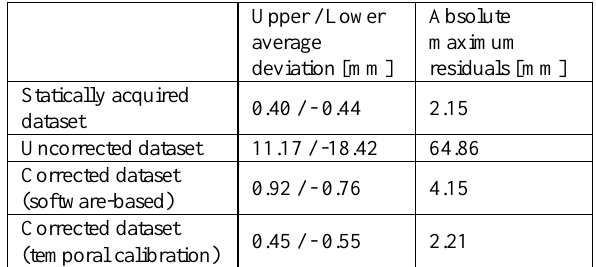
Figure 5: Model ship with mounted prisms (circles) and targets (dashed rectangles) for the sake of transformation into a common coordinate